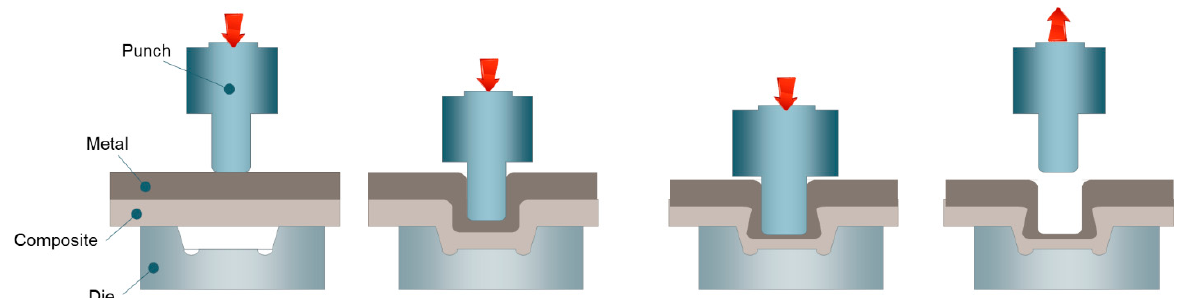
Figure 3. Schematic of the mechanical clinching joining process.